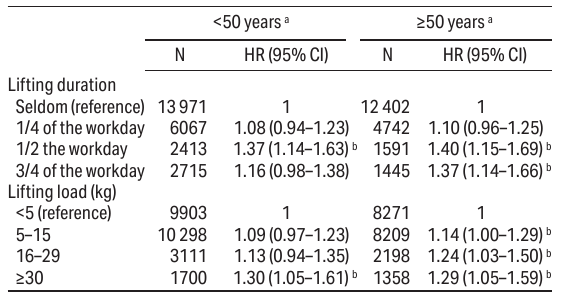
Table 3. Association between lifting duration or lifting load and risk of LTSA among all workers stratified by age <50 years and ≥50 years. [HR=hazard ratio; CI=confidence interval.]